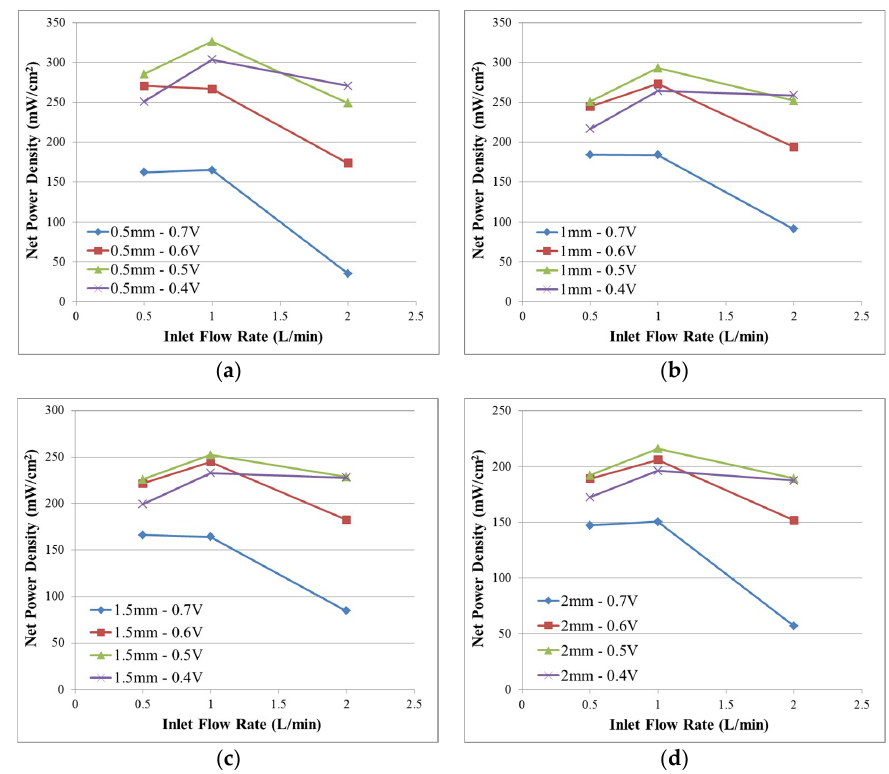
Figure 4. Comparison of net power densities that include the pumping power at different inlet flow rates and different land widths: ( a ) Land width = 0.5 mm; ( b ) land width = 1 mm; ( c ) land width = 1.5 mm; ( d ) land width = 2 mm.